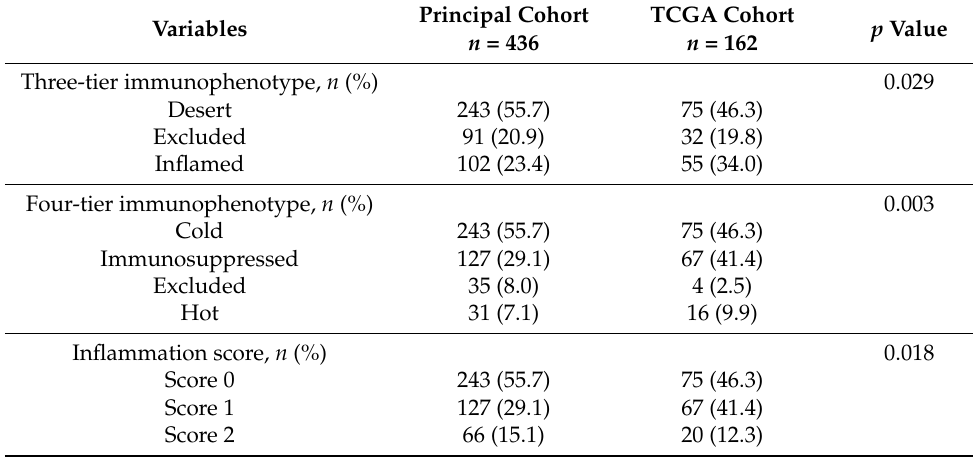
Table 2. Tumor-associated immune cells status assessed by three